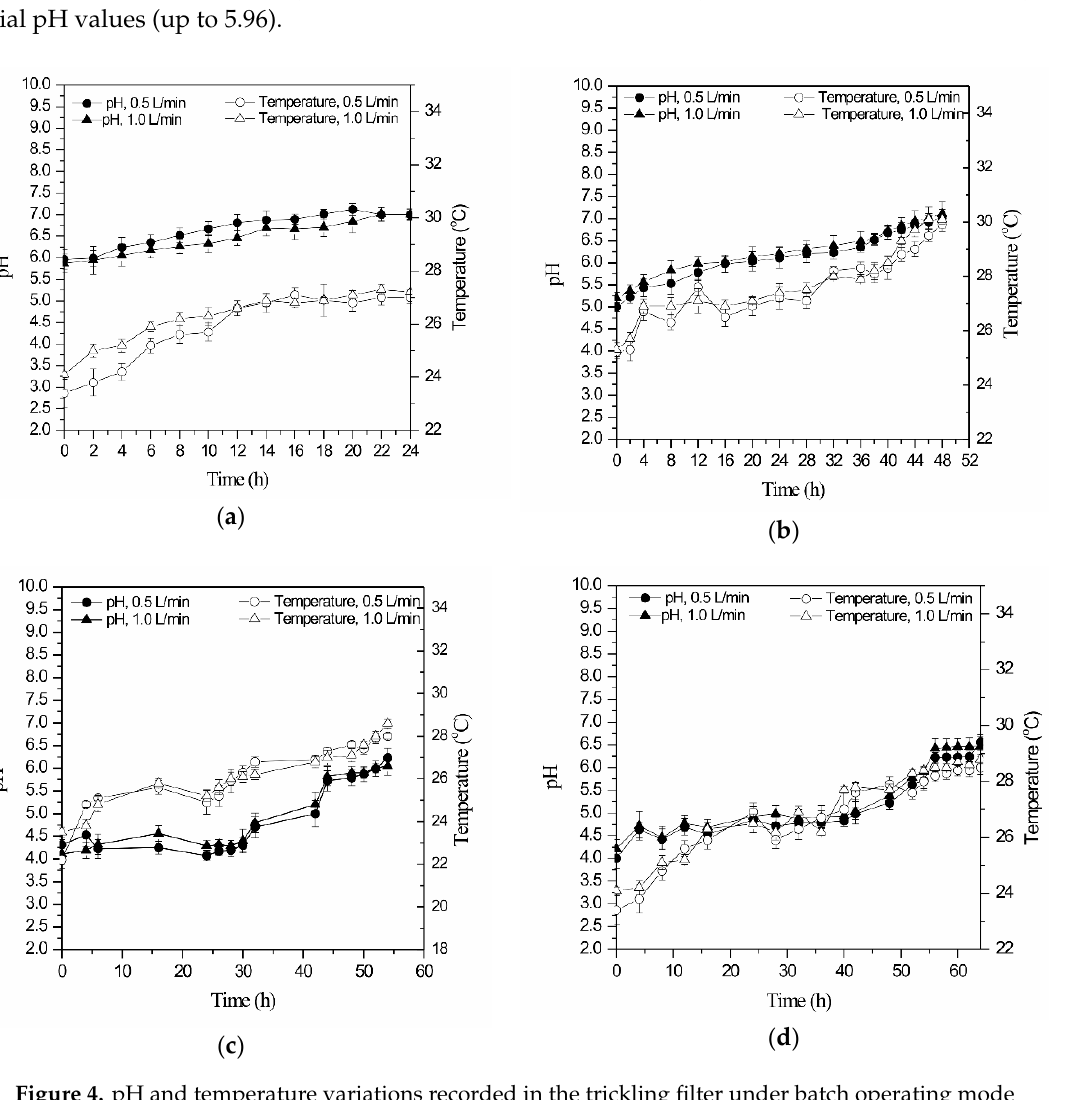
Figure 4. pH and temperature variations recorded in the trickling filter under batch operating mode with recirculation rates of 0.5 and 1.0 L/min for initial d-COD concentrations of: ( a ) 3500 mg/L, ( b ) 7500 mg/L, ( c ) 9000 mg/L and ( d ) 18,000 mg/L.